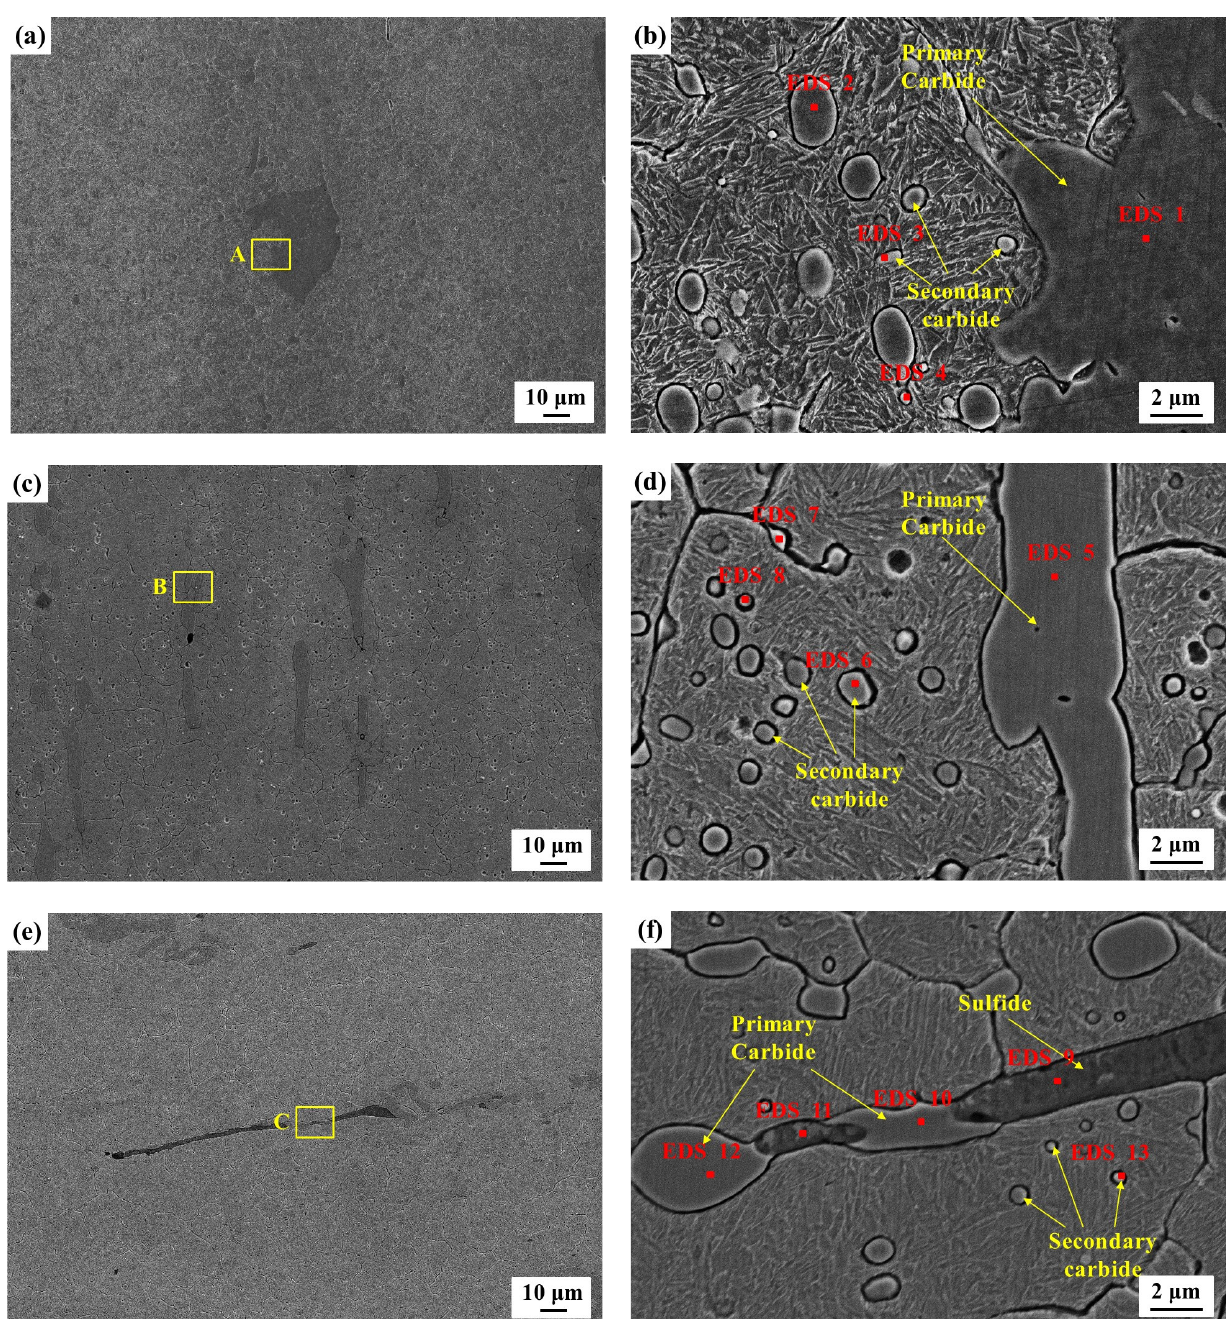
Figure 2. SEM micrographs of the tempered steel: ( a ) SKD11; ( b ) enlarged image at A in Figure 2a; ( c ) DC53; ( d ) enlarged image at B in Figure 2c; ( e ) SLD-MAGIC; ( f ) enlarged image at C in Figure 2e.